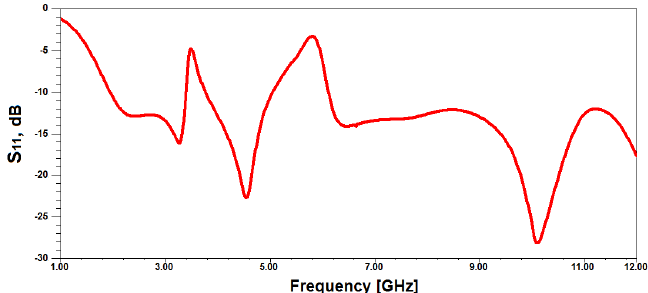
Figure 7: Simulated S 11 of the proposed dual band-notch antenna.